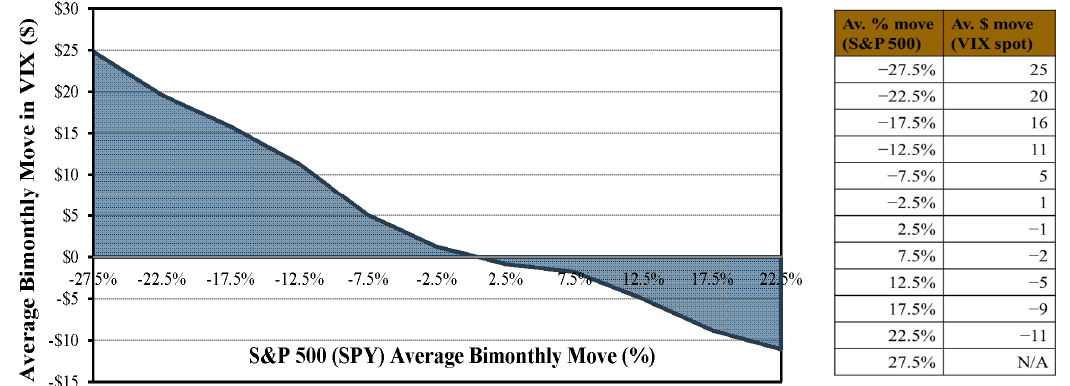
Figure 1. Bimonthly Asymmetric Relationship—Spot VIX to S&P 500 (1993–2006).